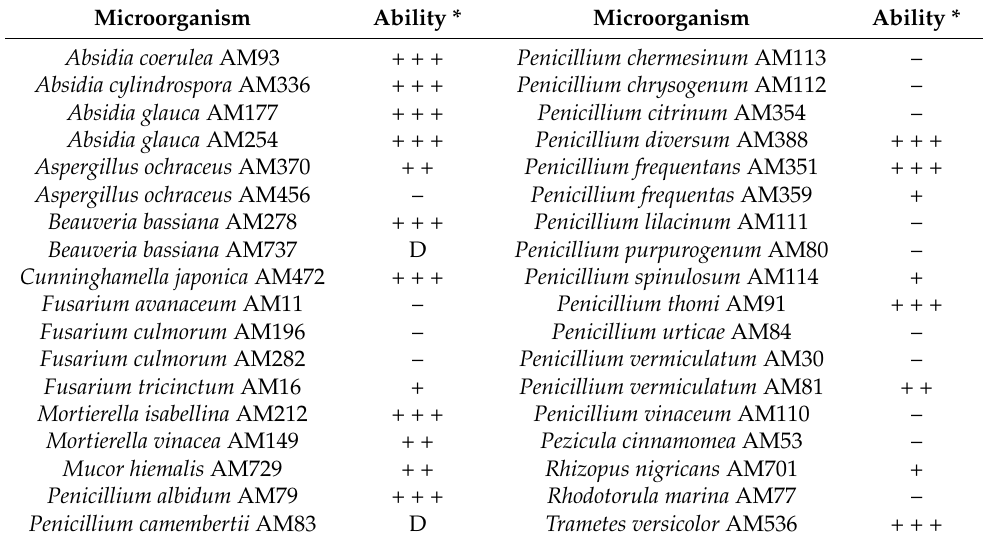
Table 3. Ability of wogonin ( 4 ) biotransformation by the tested microorganisms. Microorganism Ability * Microorganism Ability * Absidia coerulea